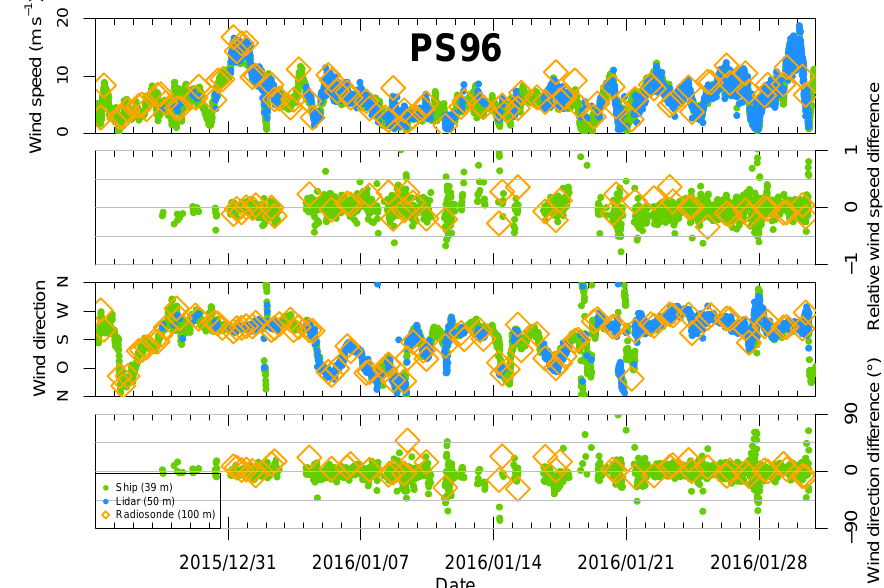
Figure 8. As Fig. 7 but for PS96 (Antarctic).